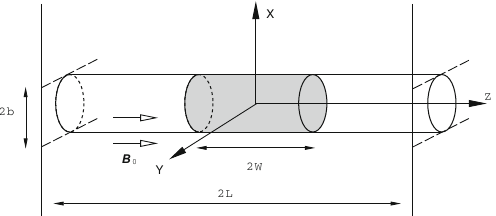
Fig. 56 Sketch of the equilibrium configuration of a thread in a cylindrical coronal magnetic tube. The gray zone of length 2 W represents the cold part of the flux tube, i.e., the prominence thread. The length of the magnetic structure is 2 L and the thread radius is b . The magnetic field is uniform and parallel to the z -axis, and the whole configuration is invariant in the ϕ -direction. Image reproduced with permission from Díaz et al. (2002), copyright by AAS